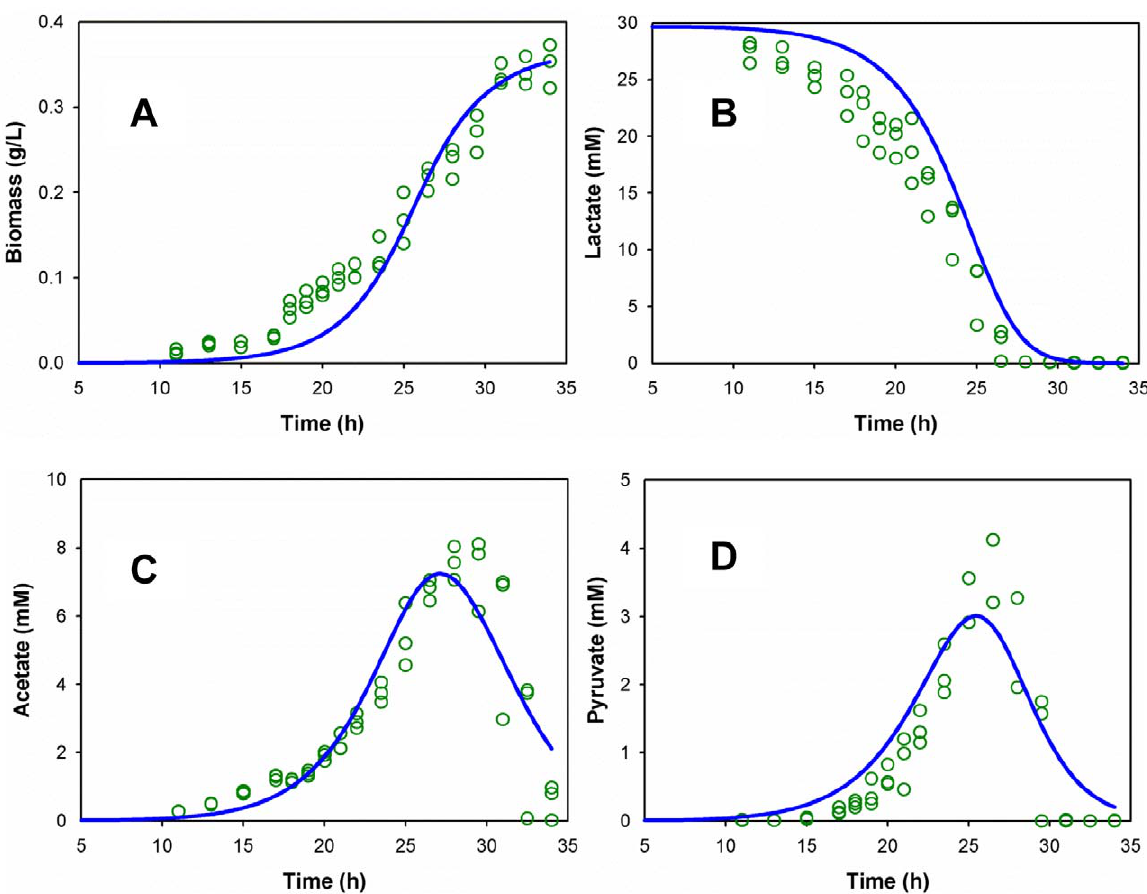
Figure 2. Monod model for growth kinetics. The green dots are the measurements, and the blue lines are the simulated growth by the empirical Monod model.